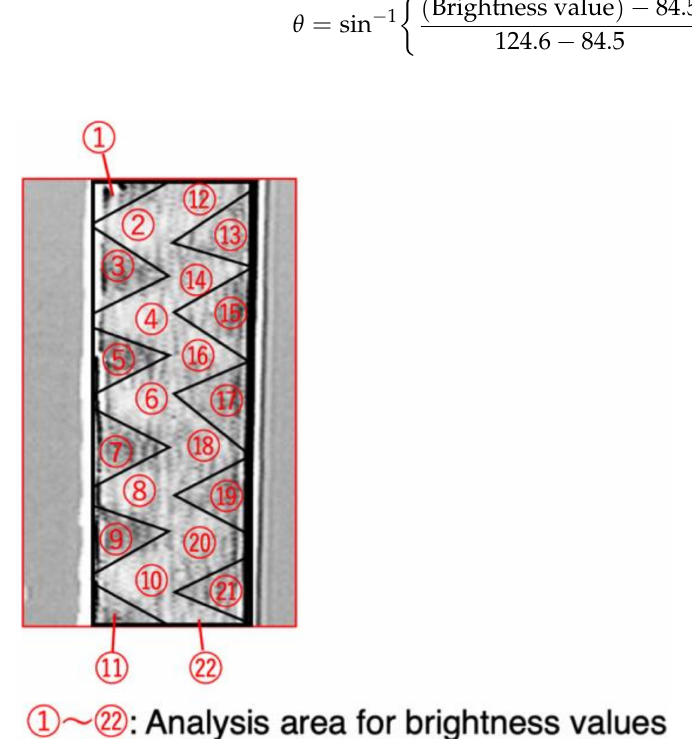
Figure 6. Section of wire shown in Figure 5a divided into 22 regions according to the magnetic domain